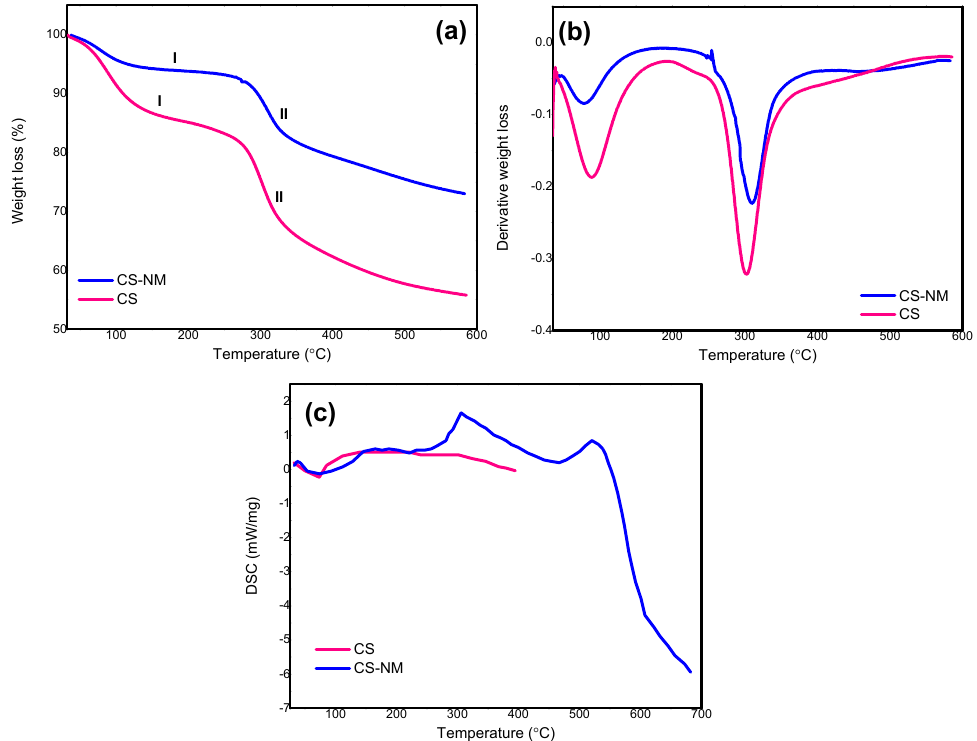
Figure 5. ( a ) TGA, ( b ) DTG, and ( c ) DSC curves of pure chitosan and CS-NM bio-composite.